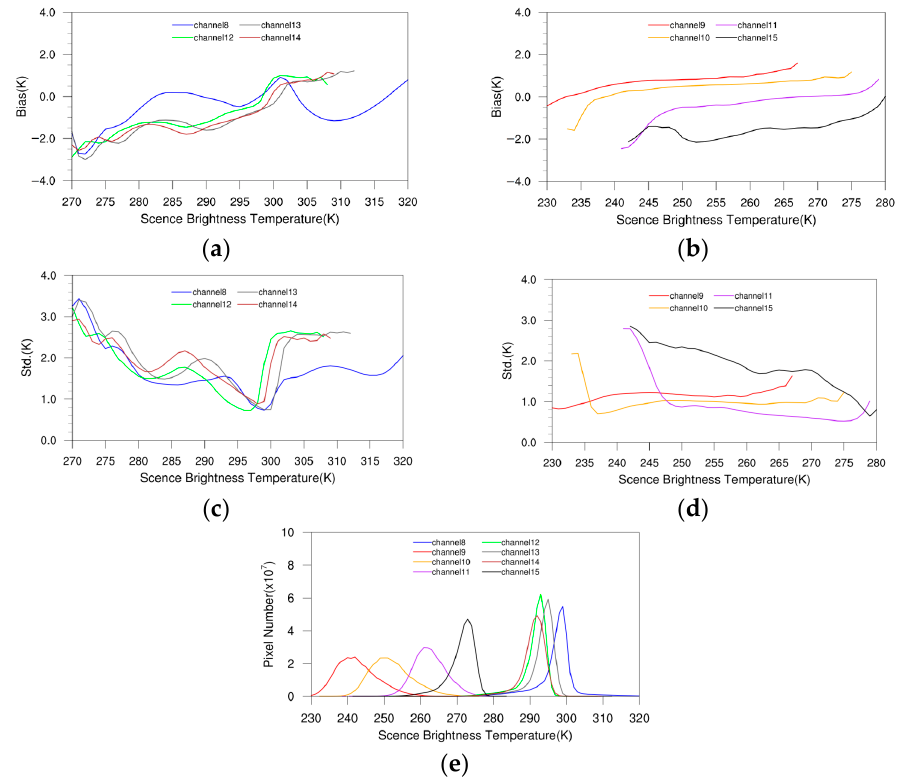
Figure 11. ( a , b ) Biases and ( c , d ) standard deviations of Fengyun-4B/AGRI IR channels’ brightness temperature observations and RTTOV simulations with respect to scene temperature calculated at 1 ◦ intervals over ocean under clear-sky conditions and with satellite zenith angles less than 60 ◦ from June to November 2022. Pixel numbers calculated at 1 K intervals are shown in ( e